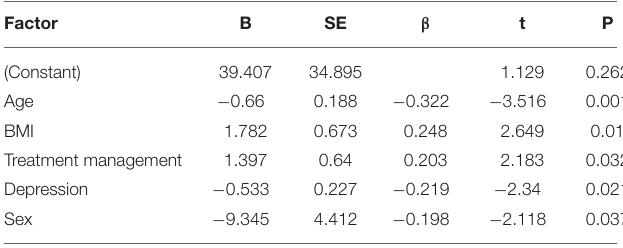
TABLE 4 | Multiple linear regression of factors influencing endogenous creatinine